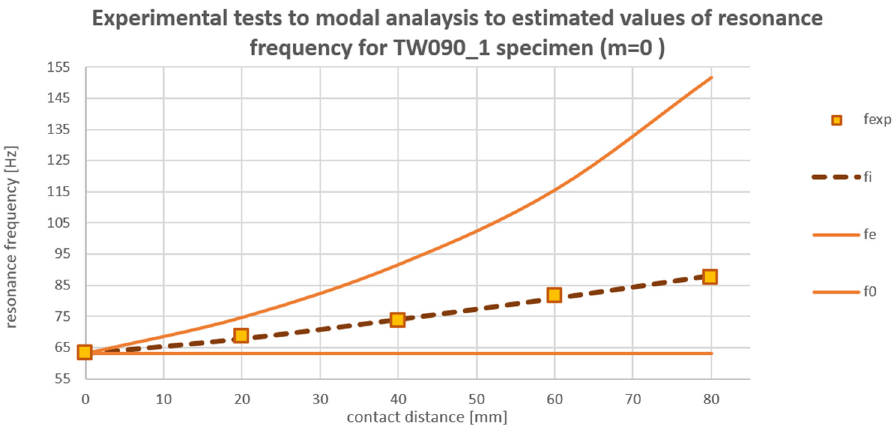
Figure 11. Comparison of experimental tests with modal analysis and estimated values of resonance frequency values for TW090_1 specimen (m = 0) .